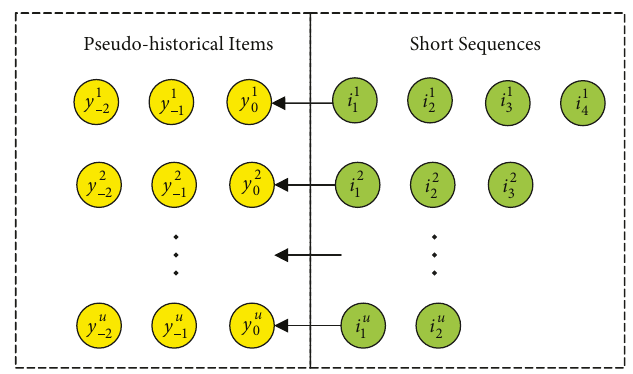
Figure 3: The example of the short-sequence enhancement process.